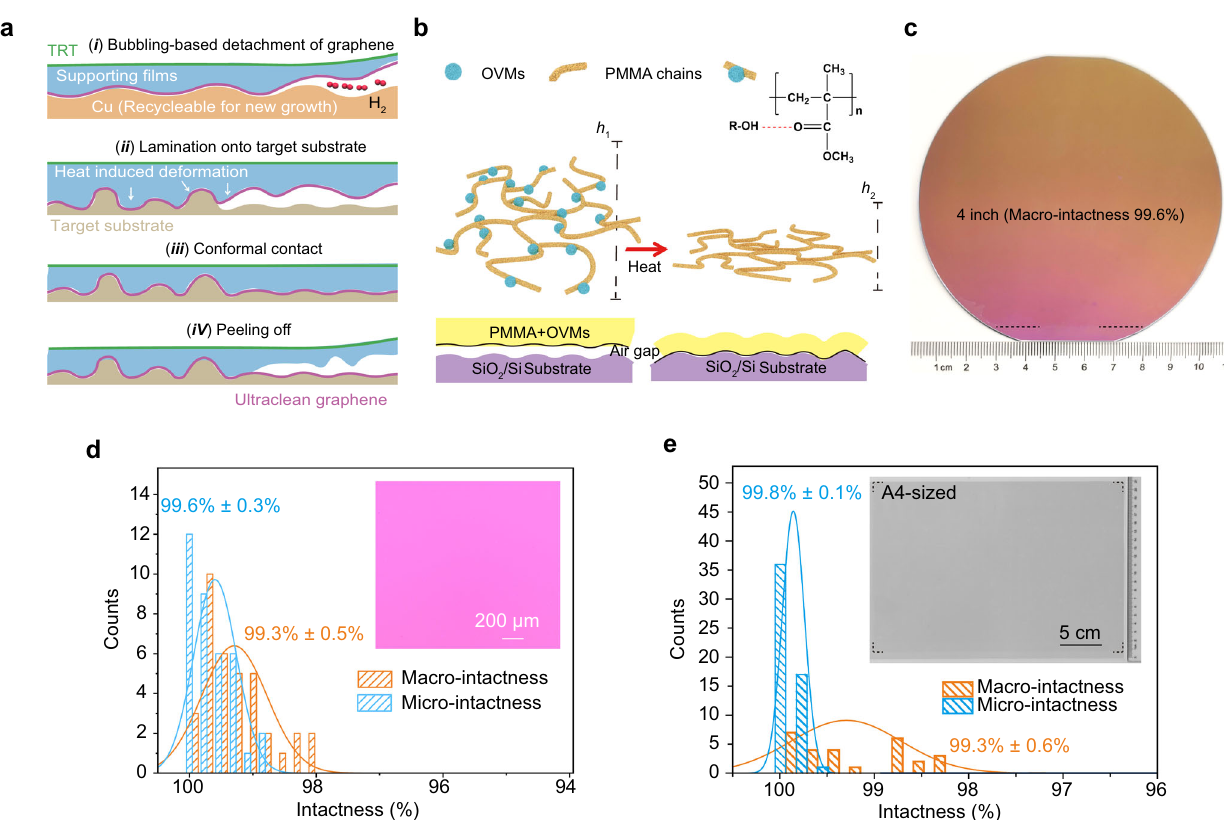
Fig. 1 The crack-free transfer of large-area graphene fi lms onto SiO 2 /Si wafers and polyethylene terephthalate (PET) substrates. a Illustration of techniques for transferring graphene onto destination substrates free of cracks and contamination. Before the bubbling-based separation, the lamination of the rigid thermal release tape (TRT) onto the supporting fi lms is essential for large-scale operability. b Mechanism illustration of the heat-induced deformation and resulted conformal contact. Heat treatment would enable the evaporation of oxhydryl groups-containing volatile molecules (OVMs) and the height change (from h 1 to h 2 ) of the supporting fi lms. c Photograph of 4-inch graphene single-crystal transferred onto SiO 2 /Si wafers. The region below the black dash line is not covered by graphene, because this region was not coated by supporting fi lms for being connected with electrodes during bubbling delamination. d , e Statistics of Macro-intactness (orange) and Micro-intactness (blue) of as-transferred graphene on 4-inch SiO 2 /Si ( d ) and A4-sized PET ( e ). d Optical microscopy (OM) image of graphene on SiO 2 /Si substrates at 5× magni fi cation. e A4-sized scanned image of graphene on PET. Note that graphene in c , d was transferred by cedrol (10